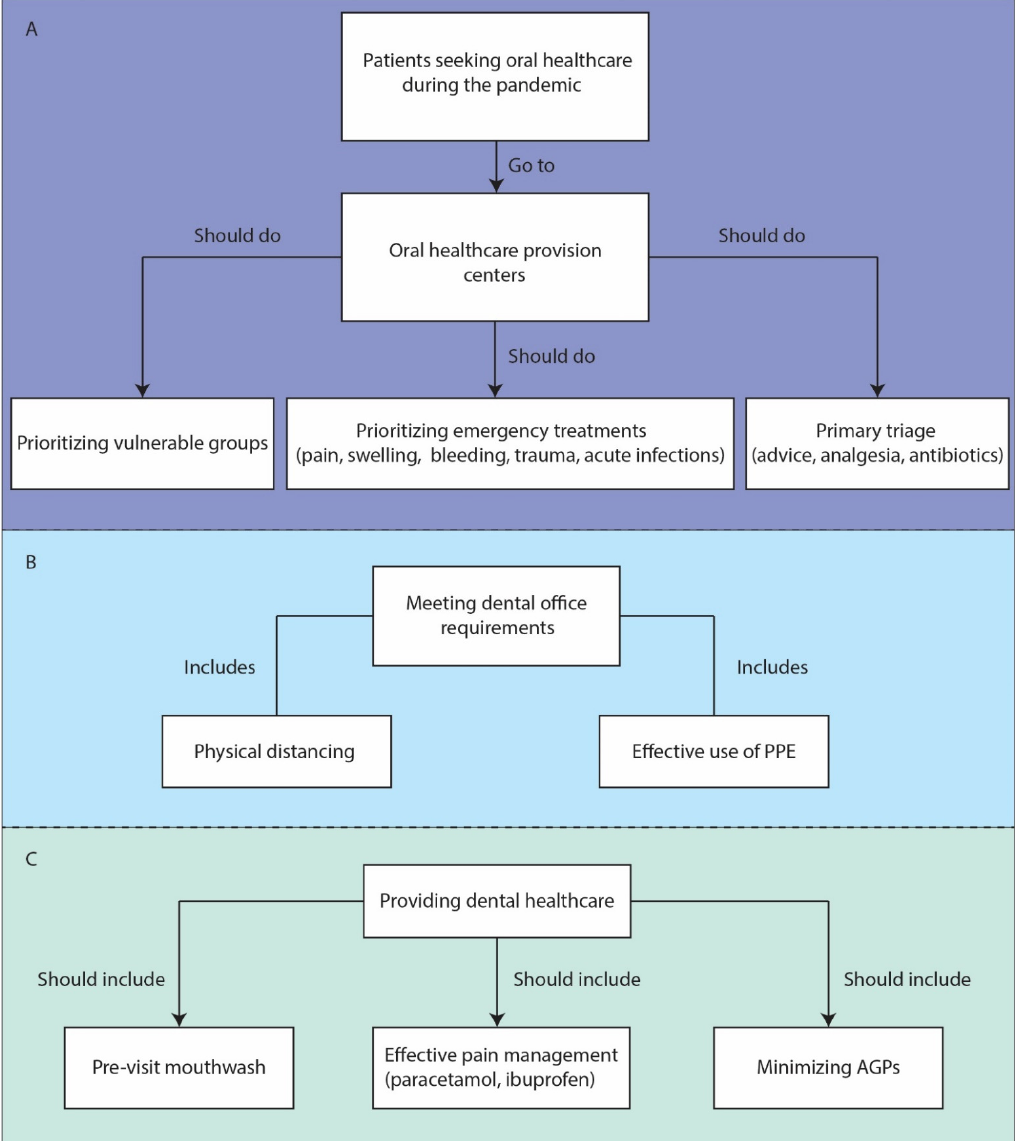
Figure 1. Recommendations for dental practice during COVID-19 pandemic. ( A ) Essential prioritization and triage. ( B ) Essential requirements of active dental offices. ( C ) Essential steps to notice in healthcare delivery. COVID-19: Coronavirus disease 2019; PPE: Personal protective equipment; AGPs: Aerosol generating procedures.